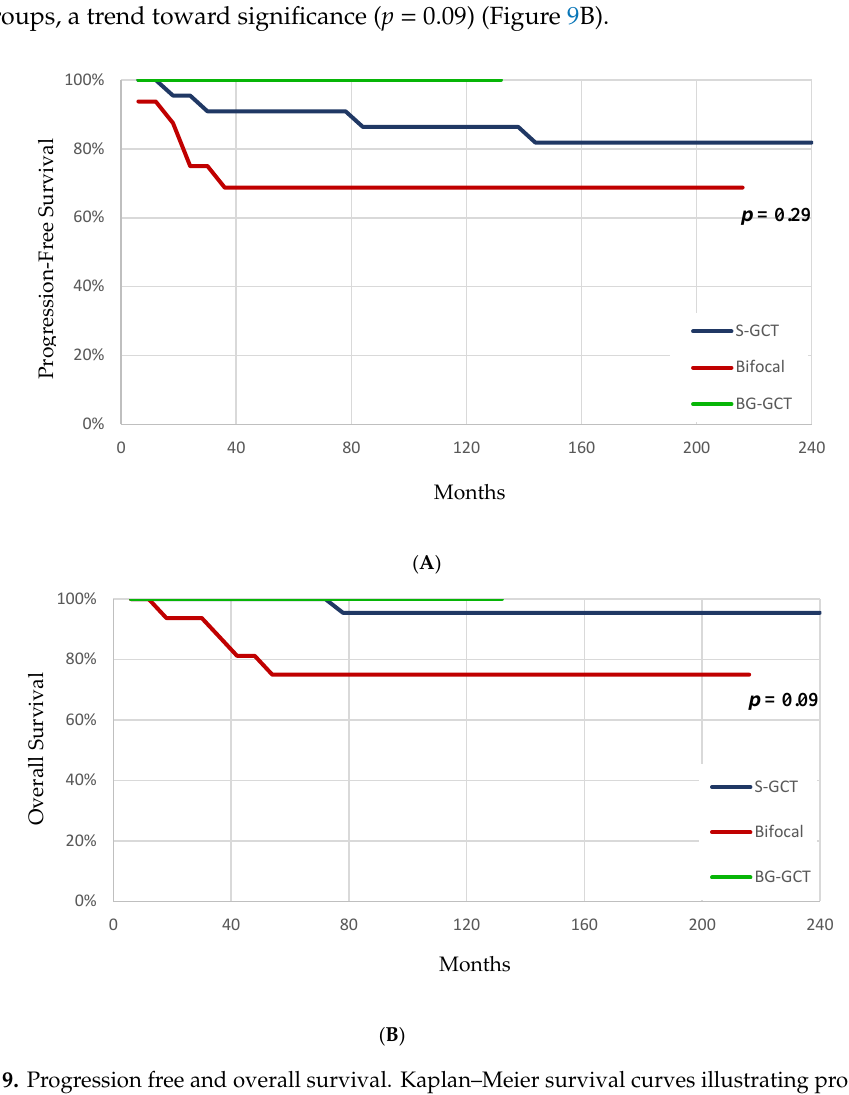
Table 5. Radiation therapy field and recurrences. Radiation Therapy